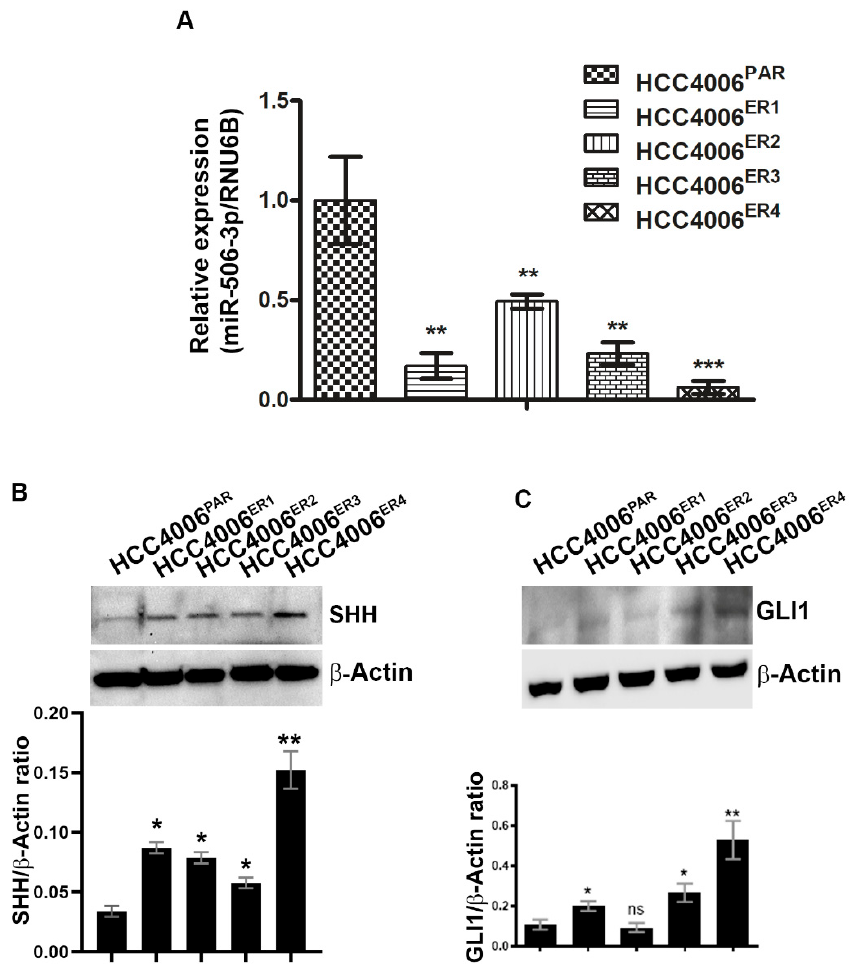
Figure 3. Downregulation of miR-506-3p and upregulation of its target Sonic Hedgehog (SHH) and glioma-associated oncogene homolog zinc finger protein 1 (GLI1) expression. ( A ) The bar graph indicates the quantitative relative expression of miR-506-3p in erlotinib-sensitive cells (HCC4006 PAR ) and erlotinib-resistant cells (HCC4006 ER1, ER3 and ER4) by real-time PCR. Data are expressed as the mean ± SD, ** p < 0.005, *** p < 0.001 when compared to HCC4006 PAR . ( B ) Western blot analysis and quantification (bar graph) of SHH protein erlotinib sensitive and resistant cells. β -actin is used as a loading control. Data show the mean ± SD and are representative of at least three independent experiments. * p < 0.01, ** p < 0.003 when compared to HCC4006 PAR . ( C ) Detection and quantification (bar graph) of GLI1 protein level in sensitive and resistant cells using Western blot analysis. β -actin is used as a loading control. Data are expressed as the mean ± SD ns, non-significant and * p < 0.01, ** p < 0.007 when compared to HCC4006 PAR .